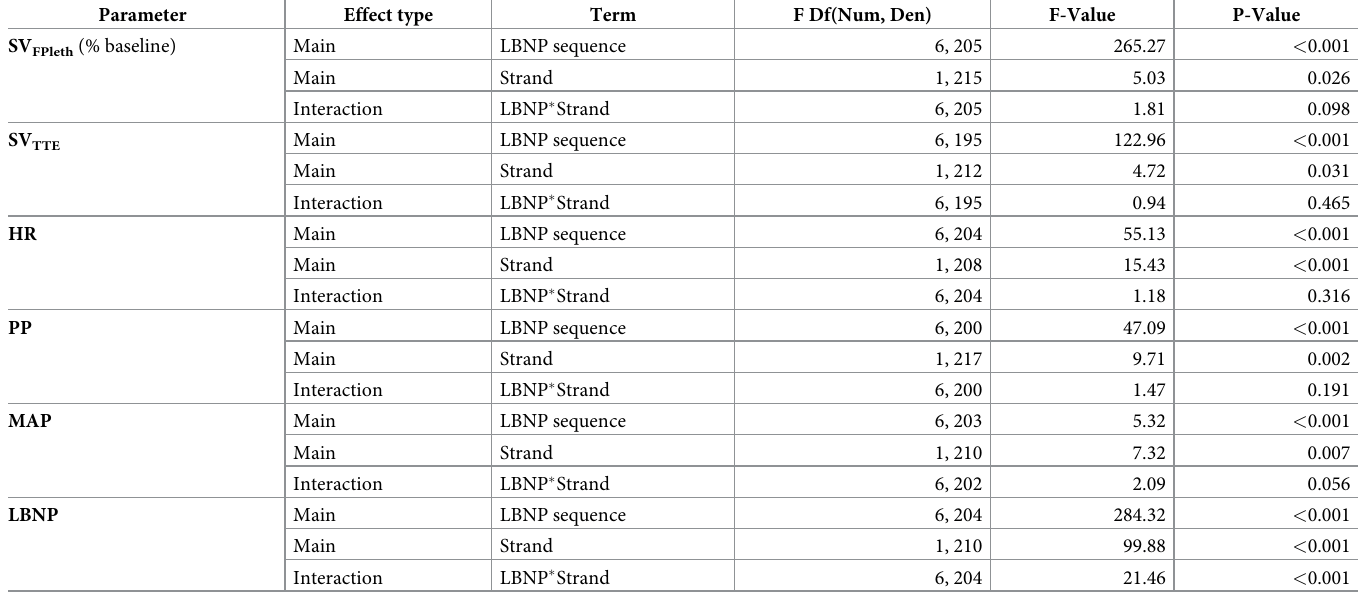
Abbreviations for the parameters are as listed in Fig 1. The main effects of LBNP sequence (Time) and Strand (Tourniquet / No tourniquet), and the interaction of